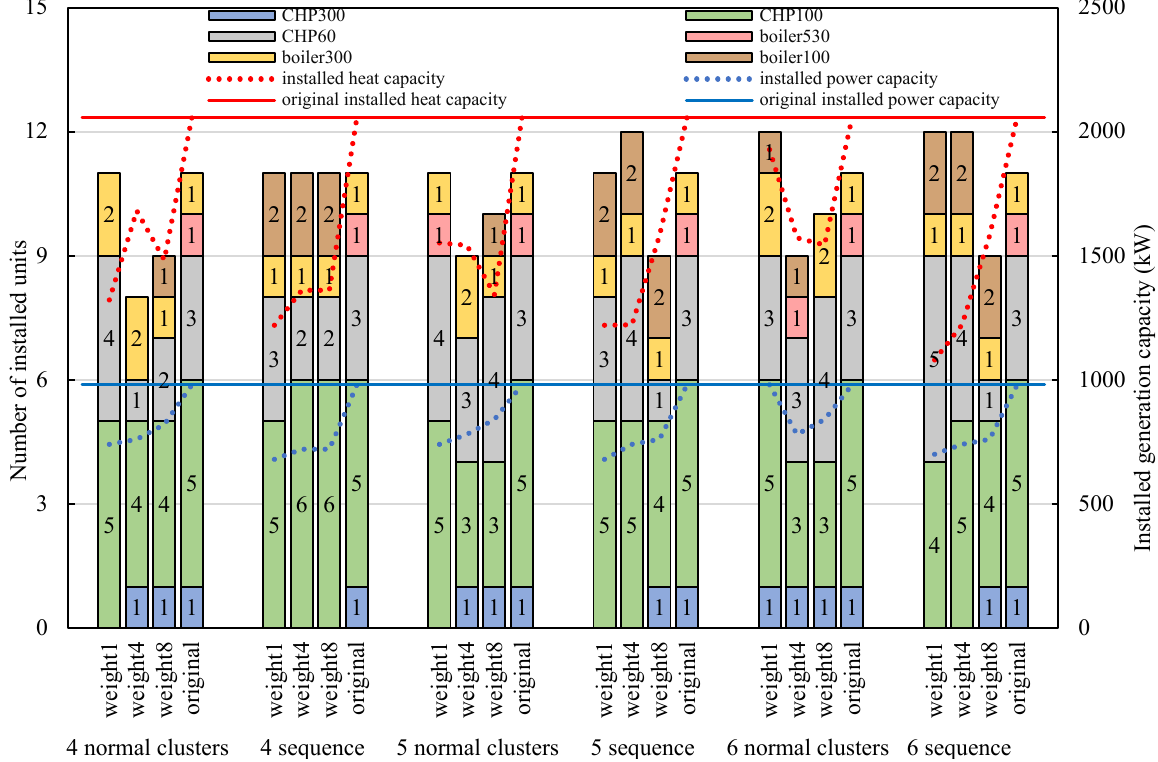
Figure 8. Design results comparison between original and clustered energy hub models.